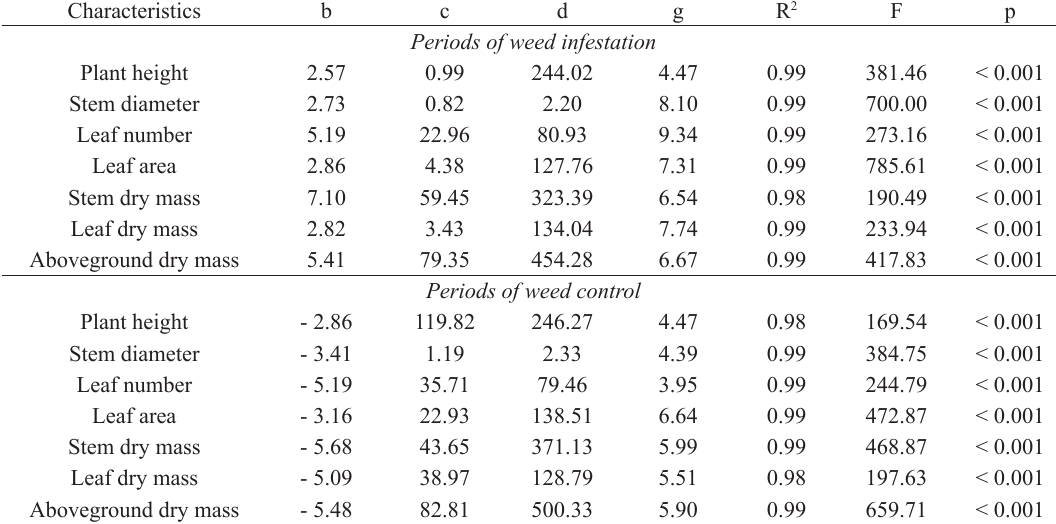
Parameters of the non-linear, log-logistic equation # adjusted to different growth characteristics of Hevea brasiliensis submitted to crescent periods of weed infestation or weed